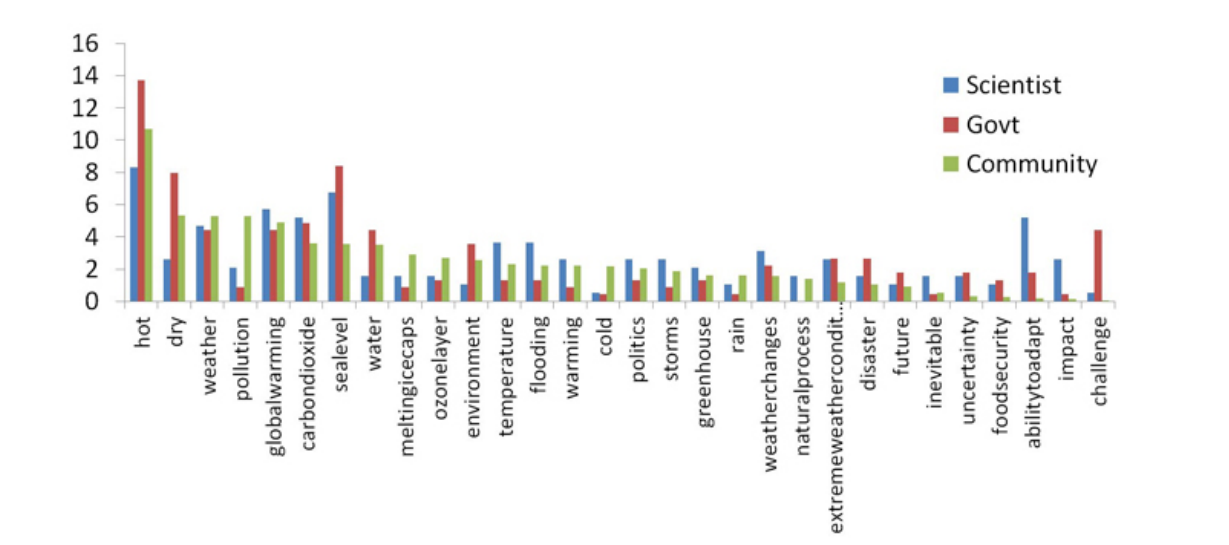
Fig. 4. Histogram of frequency magnitude for each word category associated with climate change within each of three respondent groups: scientists/academics/researchers, government employees, and community